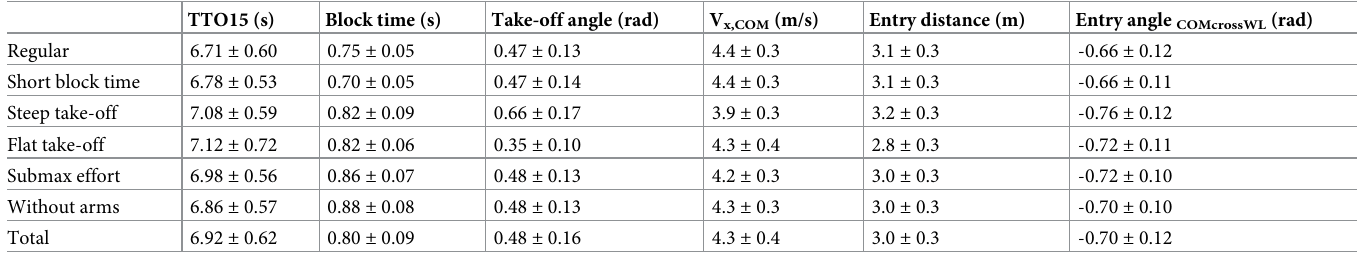
Table 5. TTO15 and block and entry state variable values for each condition (mean ± standard deviation). TTO15 (s) Block time